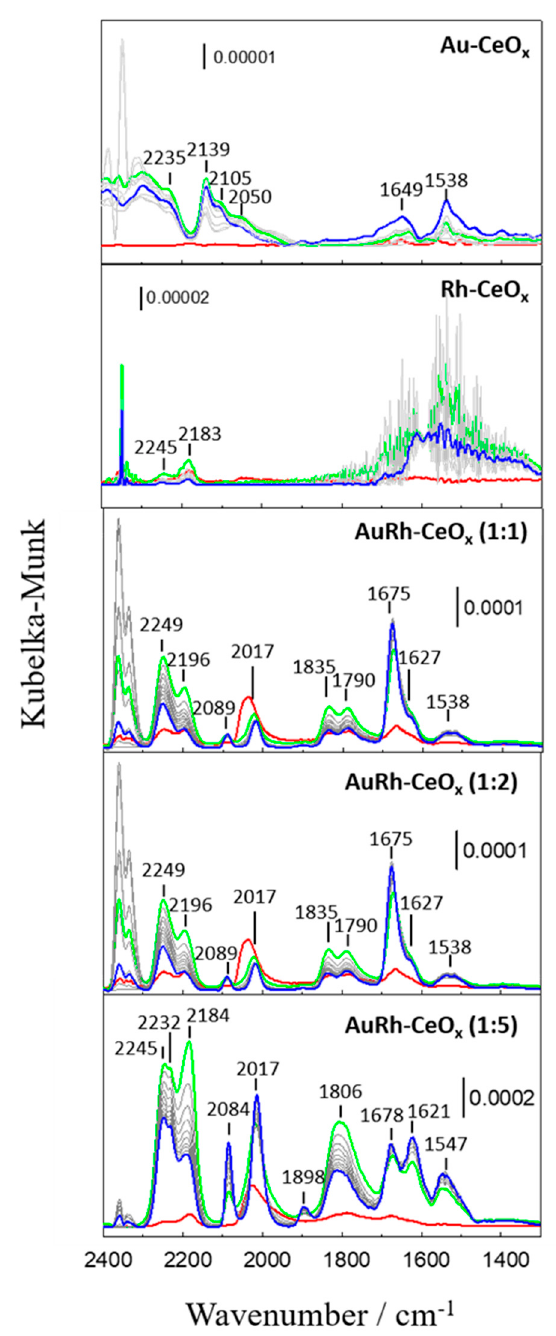
Figure 13. In situ DRIFTS spectra measured during NO–CO reaction on the Au–CeO x /Al 2 O 3 , Rh– CeO x /Al 2 O 3 , and AuRh–CeO x /Al 2 O 3 catalysts with different molar ratios of AuRh:Ce at 200 °C for 10 min (from the red line to the blue line at an interval of 1 min). Gas mixture: 2000 ppm NO, 2000 ppm CO, and He balance; total flow rate: 100 mL/min.